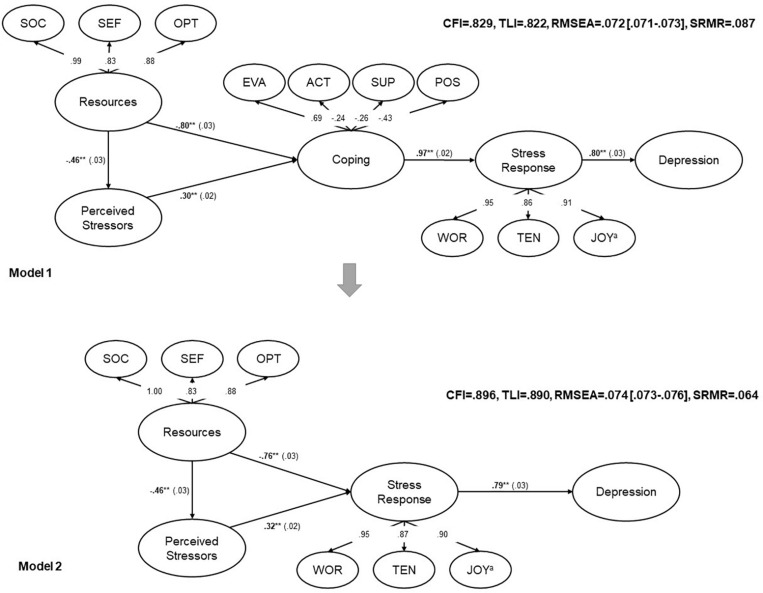
Comparison of the two structural models. Circles: unobserved latent variables, numbers next to the arrows: standardized path coefficients, **p < 0.001, SE in parentheses. aInverted items on this factor. SOC, Sense of coherence; SEF, Self-efficacy; OPT, Optimism; EVA, Evasive coping; ACT, Active coping; SUP, Support seeking; POS, Focus on positive; WOR, Worries; TEN, Tension; CFI, Comparative Fit Index; TLI, Tucker–Lewis Index; RMSEA, root mean square error of approximation, 90% CI in square brackets; SRMR, standardized root mean square residual.